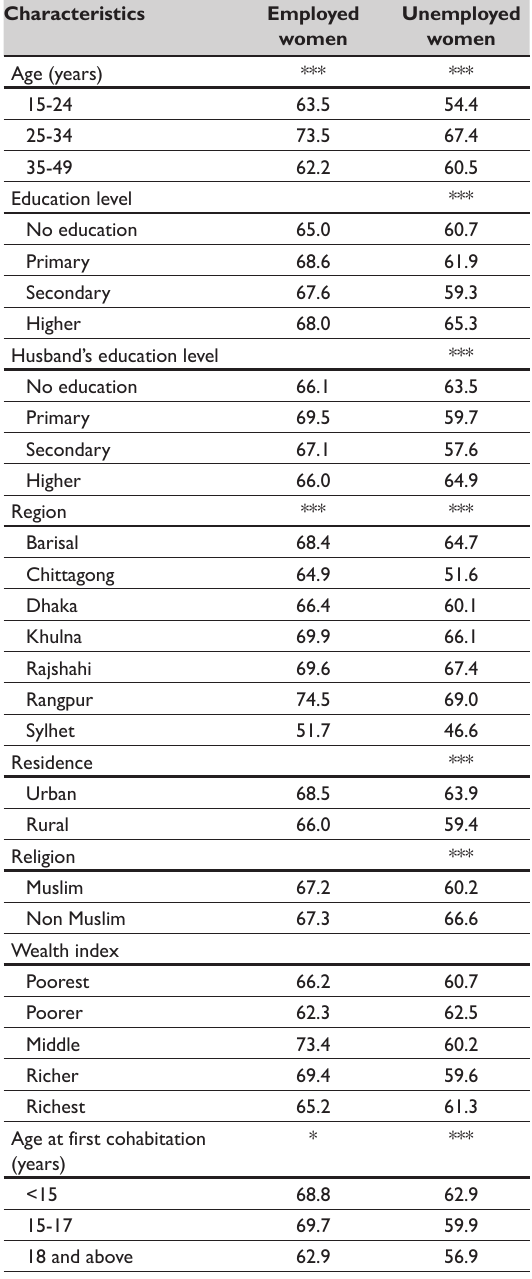
Table 2: Percentage of women who use any contraceptive according to their socio‑demographic